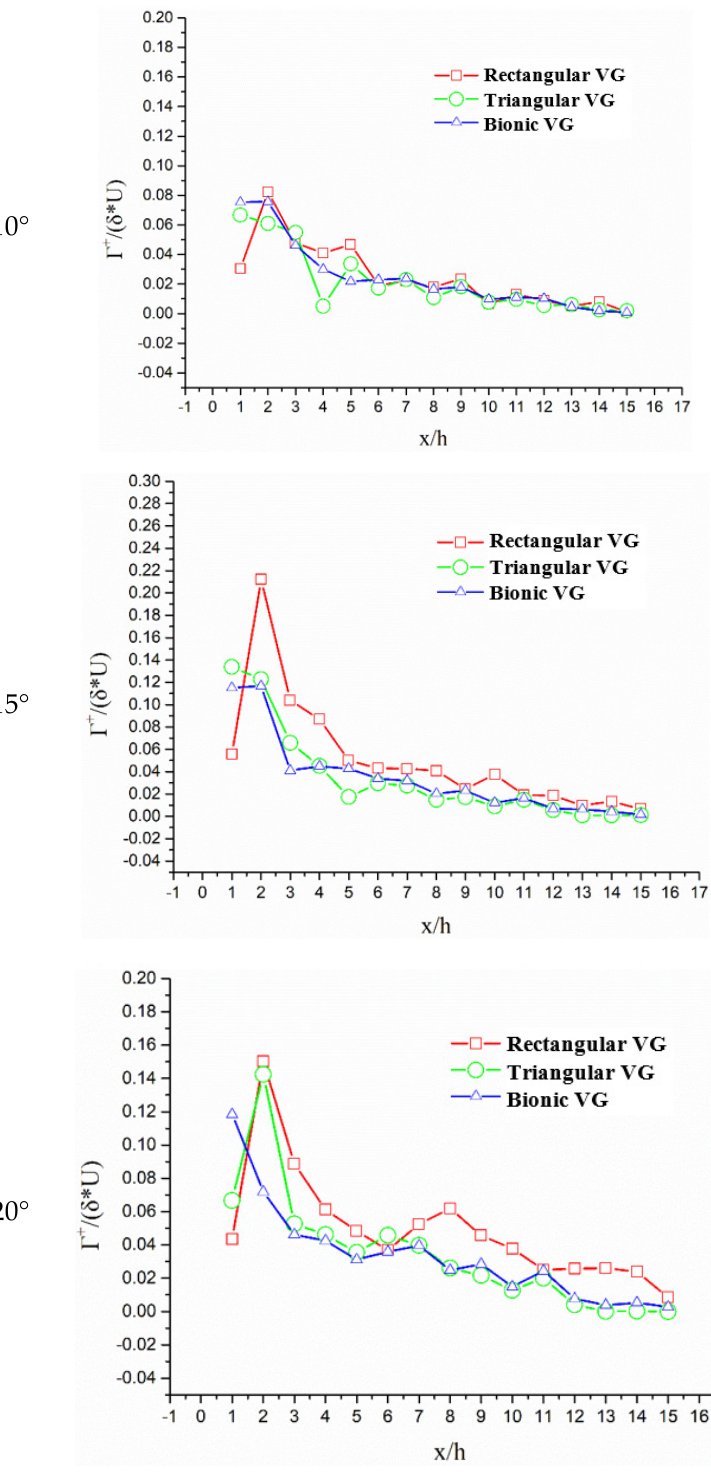
Figure 6. Vortex strength variation at a 0.9 confidence level.